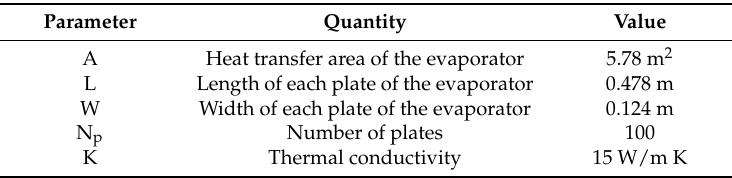
Figure 3. Plate heat exchanger [27]. Table 1. Geometrical parameters of the evaporator.